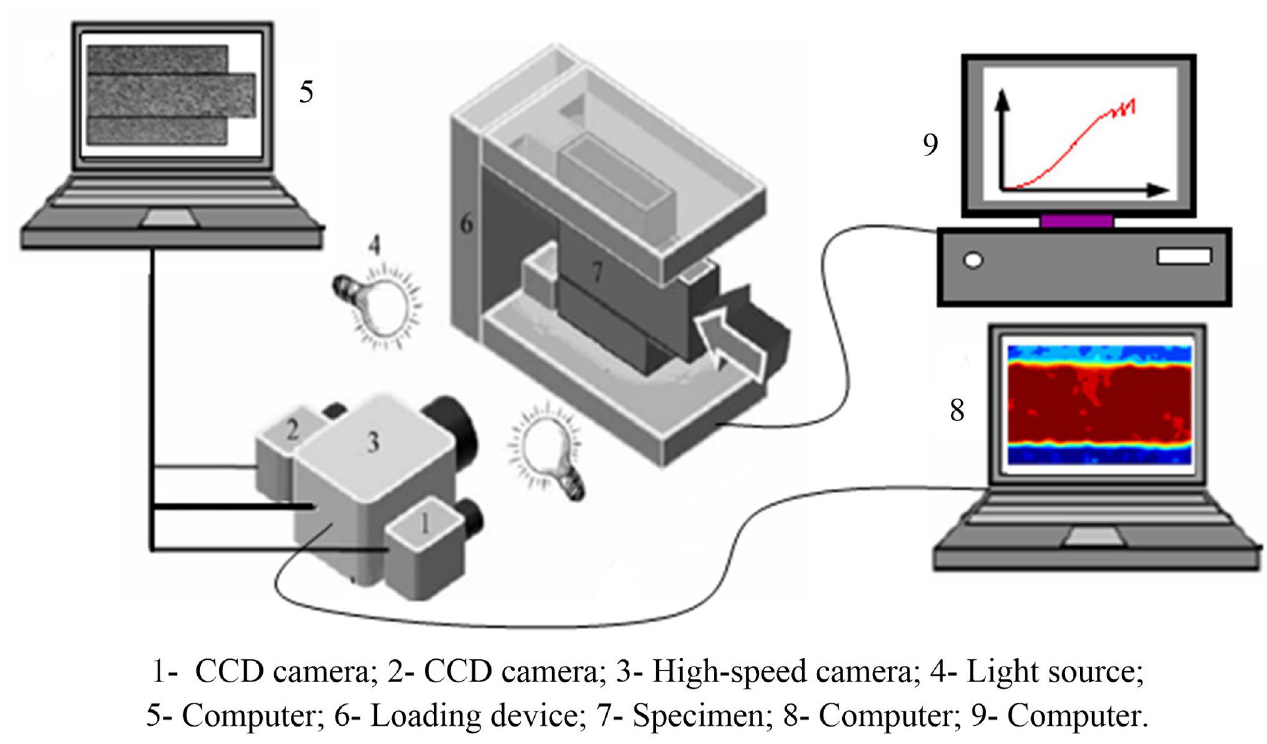
Fig 2. Schematic of the test